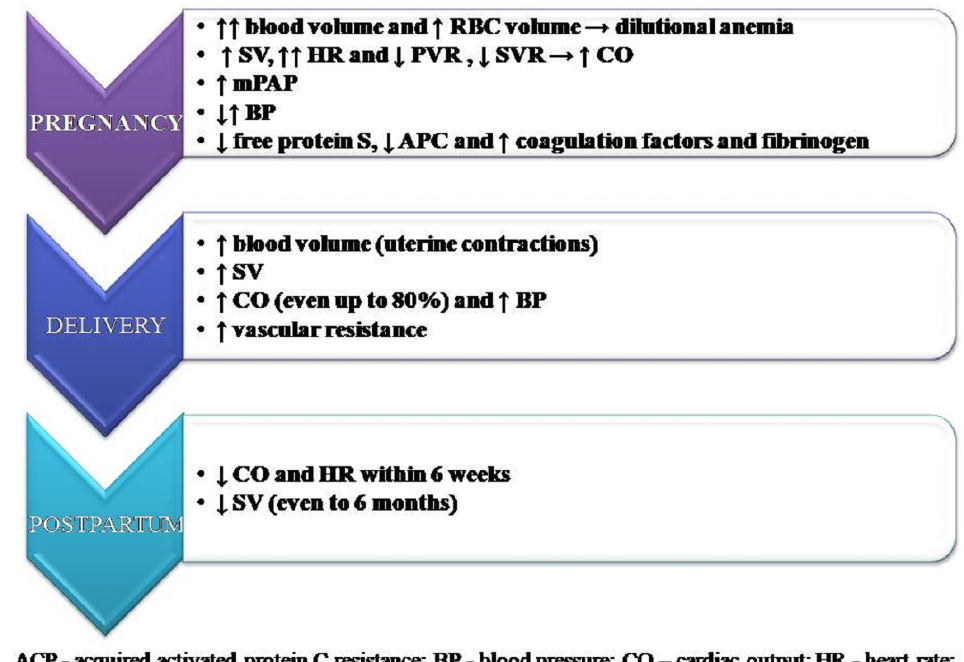
Figure 2. Key hemodynamics changes in pregnancy.